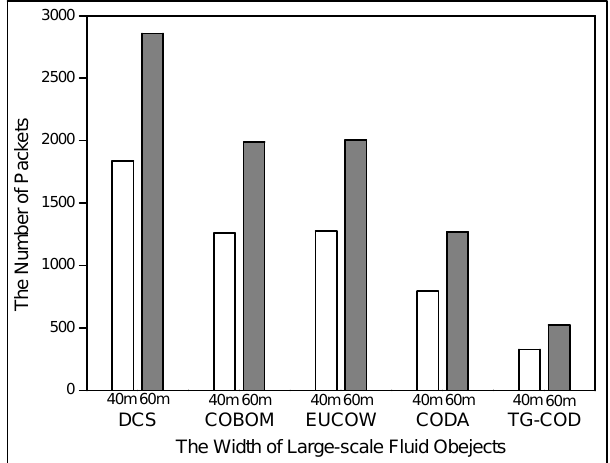
Figure 8. Experimental results for cost with transmission range